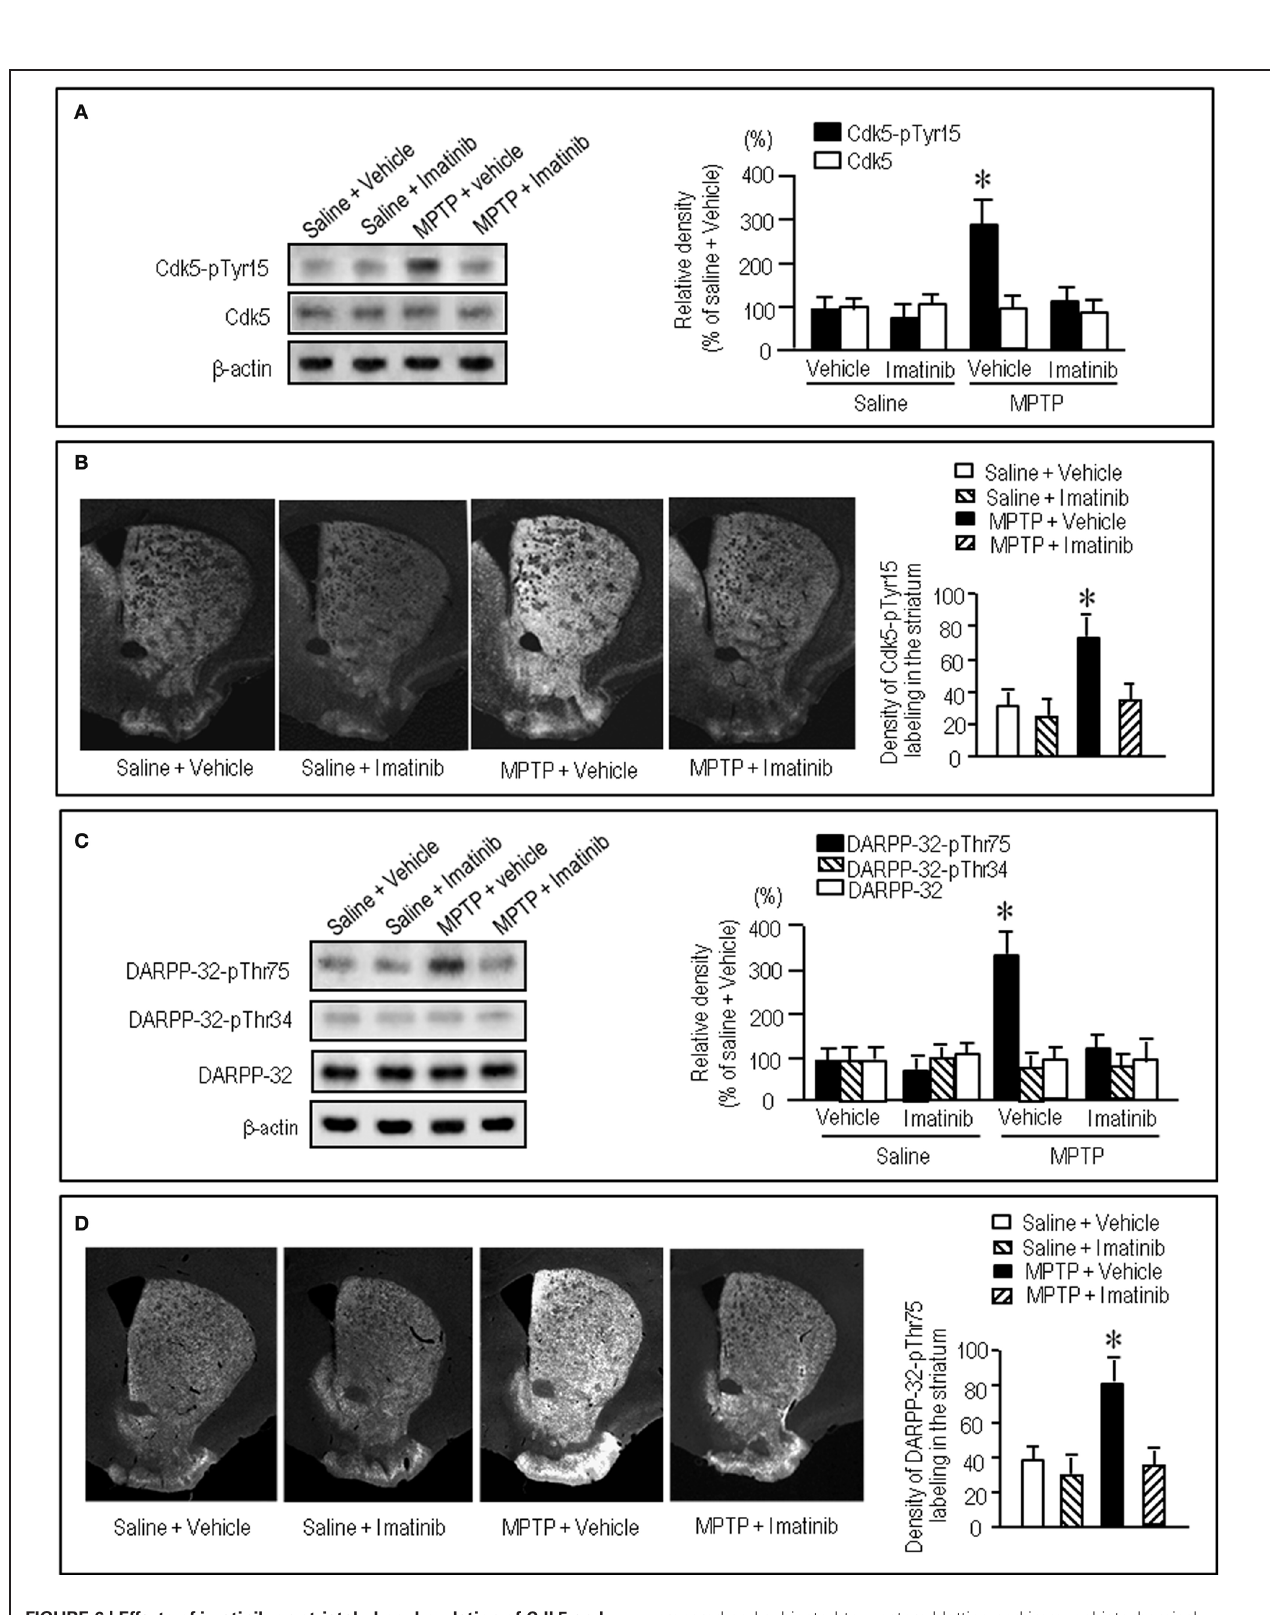
FIGURE 6 | Effects of imatinib on striatal phosphorylation of Cdk5 and DARPP-32 in MPTP mice. Saline- or MPTP-treated received vehicle or imatinib 30min before sacrifice. Striatal tissue extracts and sections